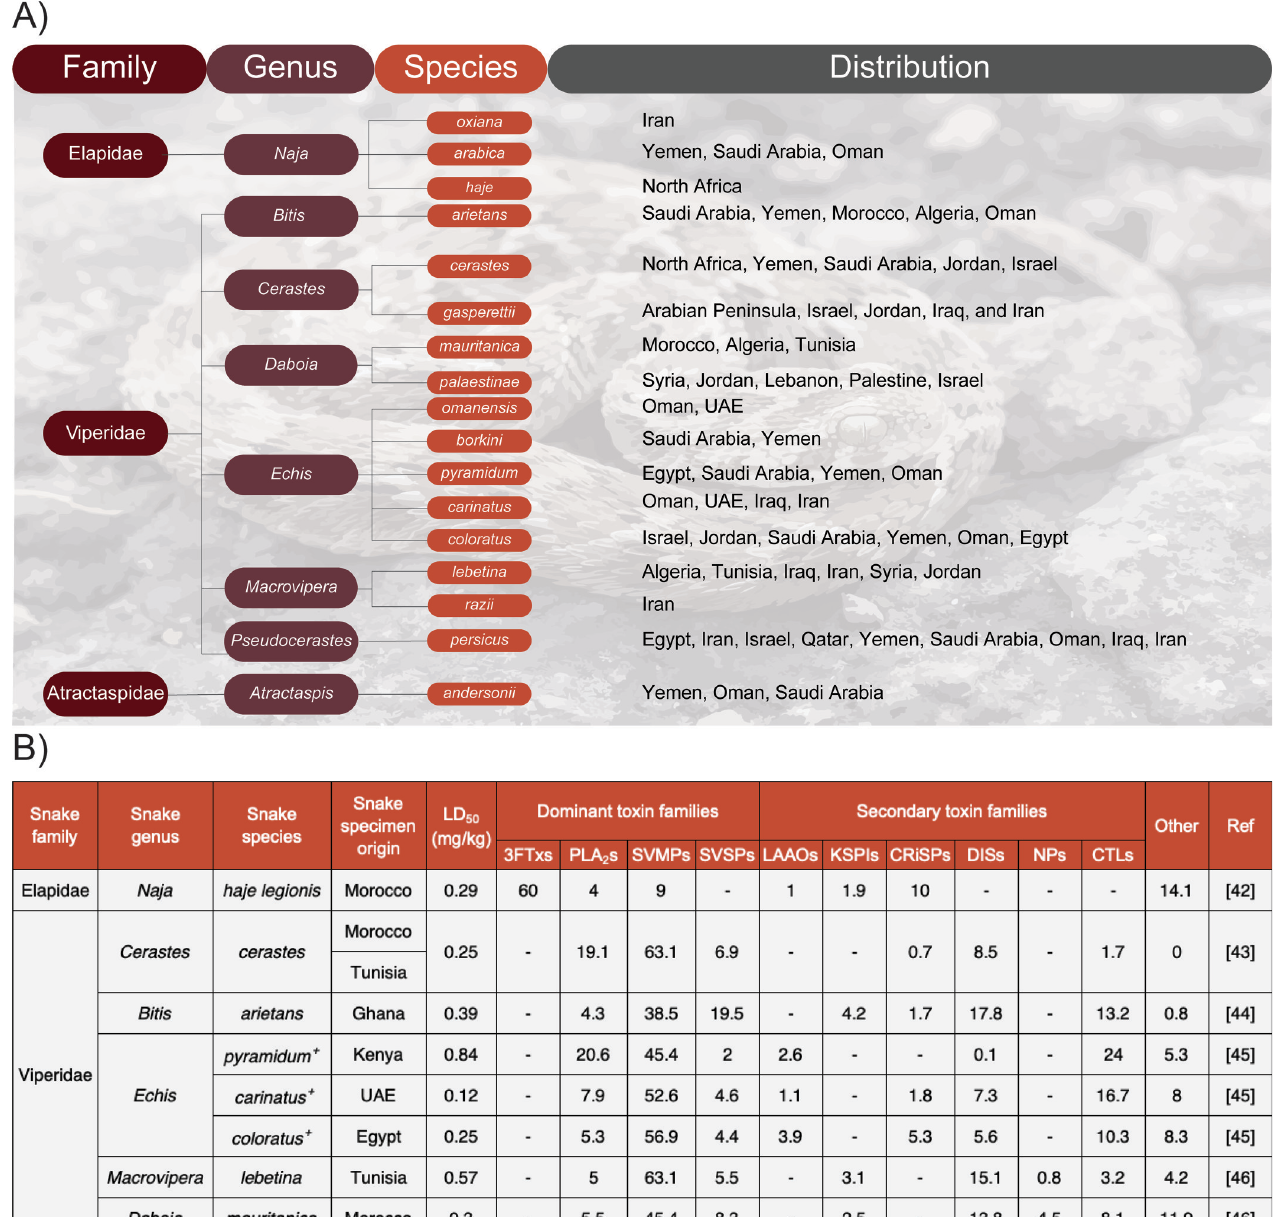
Fig 1. Medically relevant Category I snakes in North Africa and the Middle East. (A) Phylogeny and geographic distribution and (B) reported toxicity and available venom proteome or transcriptome ( + ) data are shown. Specifically, the table presents the genera, species, the origin of the reference proteome or transcriptome, and the median lethal dose in mice (LD 50 ; mg/kg) [42–46].It also illustrates the relative abundance of 3FTxs, PLA 2 s, SVMPs, SVSPs, LAAOs, KSPIs, CRiSPs, DISs, NPs, and CTLs. All components are represented as relative wet weight abundance in %. Notably, snake venom composition may vary depending on region. 3FTx, three-finger toxin; CRiSP, cysteine-rich secretory protein; CTL, C-type lectin; DIS, disintegrin; KSPI, kunitz-type serine protease inhibitor; LAAO, L-amino acid oxidase; NP, natriuretic peptide; PLA 2 s, phospholipase A 2 s; SVMP, snake venom metalloprotease; SVSP, snake venom serine